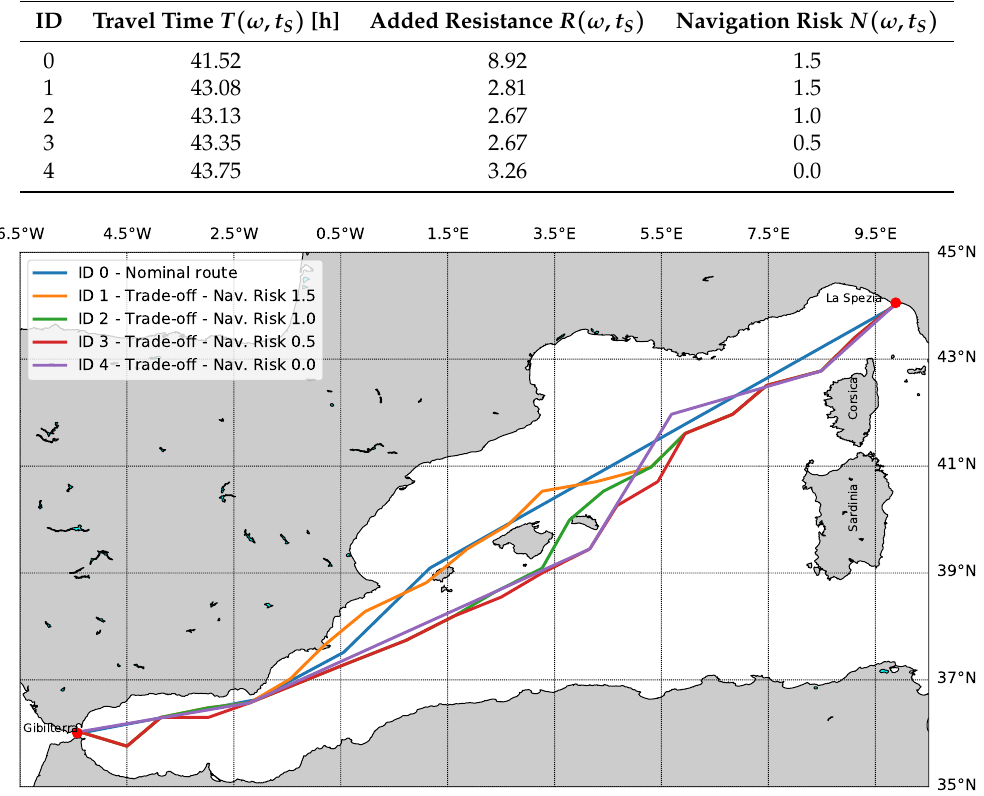
Figure 10. Set of Pareto routes representing the candidate trade-off solution for each navigation risk threshold compared with the nominal route in blue color (provided by the web-service searoutes. com